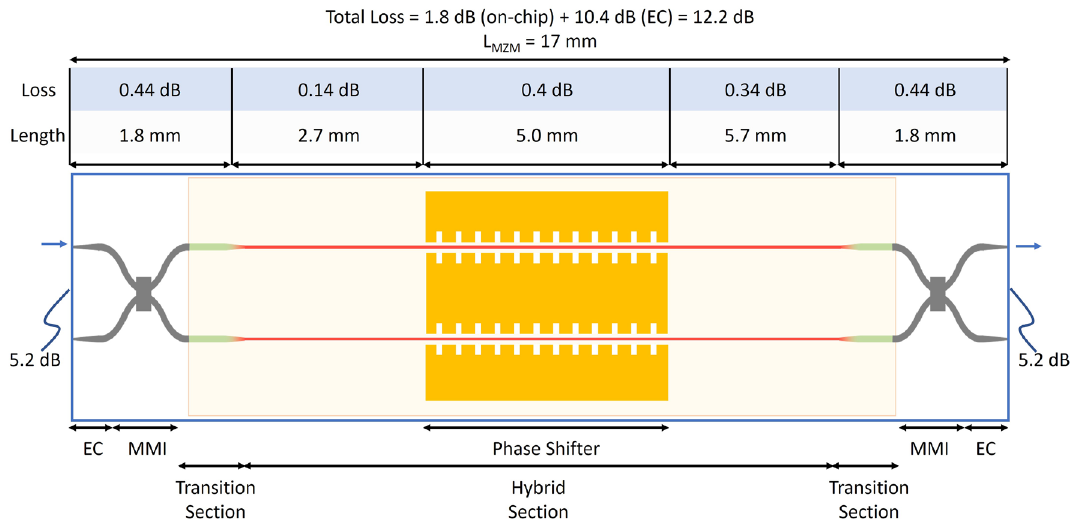
Figure 6. A (not to scale) schematic of the hybrid bonded Si/LN MZM showing the total measured insertion loss and the loss attributed to the edge coupler (EC), transition, hybrid, and phase shifter